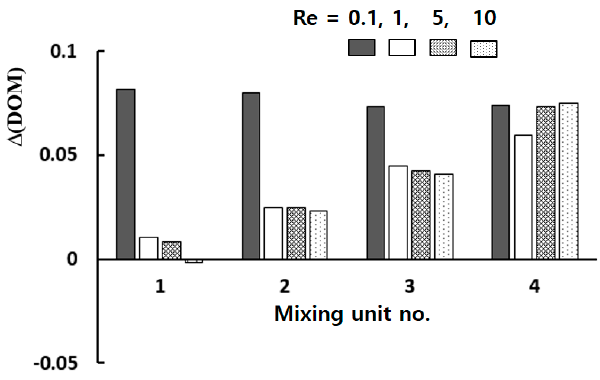
Figure 10. Increment of the DOM by tip clearance.